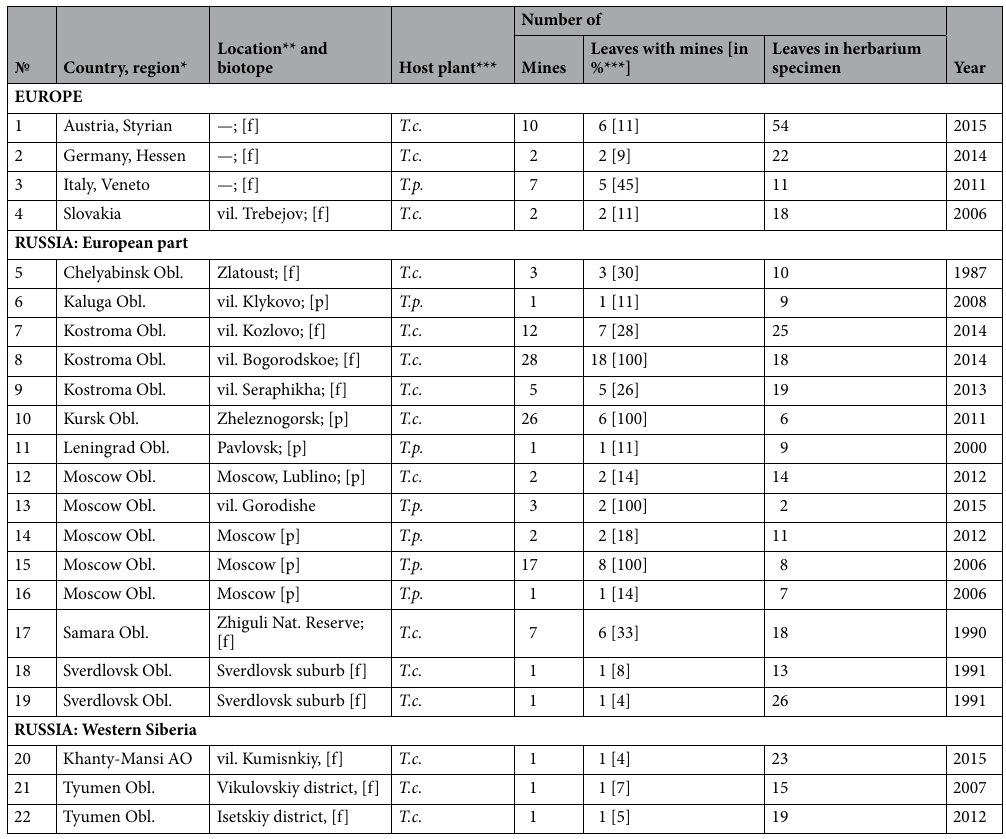
Table 1. Host plants and level of attack (% of mined leaves) of Phyllonorycter issikii found in 22 herbarium samples collected across the Western Palearctic between 1987 and 2016. *Obl., Oblast; **—, no data; vil., village; f, forest; p, park; *** T.c. , Tilia cordata ; T.p. , Tilia platyphillos ; ****Percentage of mined leaves was calculated as number of mined leaves over total of examined leaves